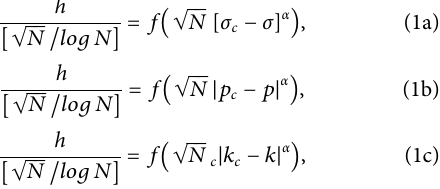
with the asymptotically well-de fi ned fi nite size scaling function f ( f ( x ) = constant at x = 0 and f remaining continuous and fi nite as x approaches in fi nity) for systems of size N (total number of fi bers or lattice sites/bonds) or size N c (total number of citations of all the publications by an individual scientist) and α denoting the appropriate scaling exponent.